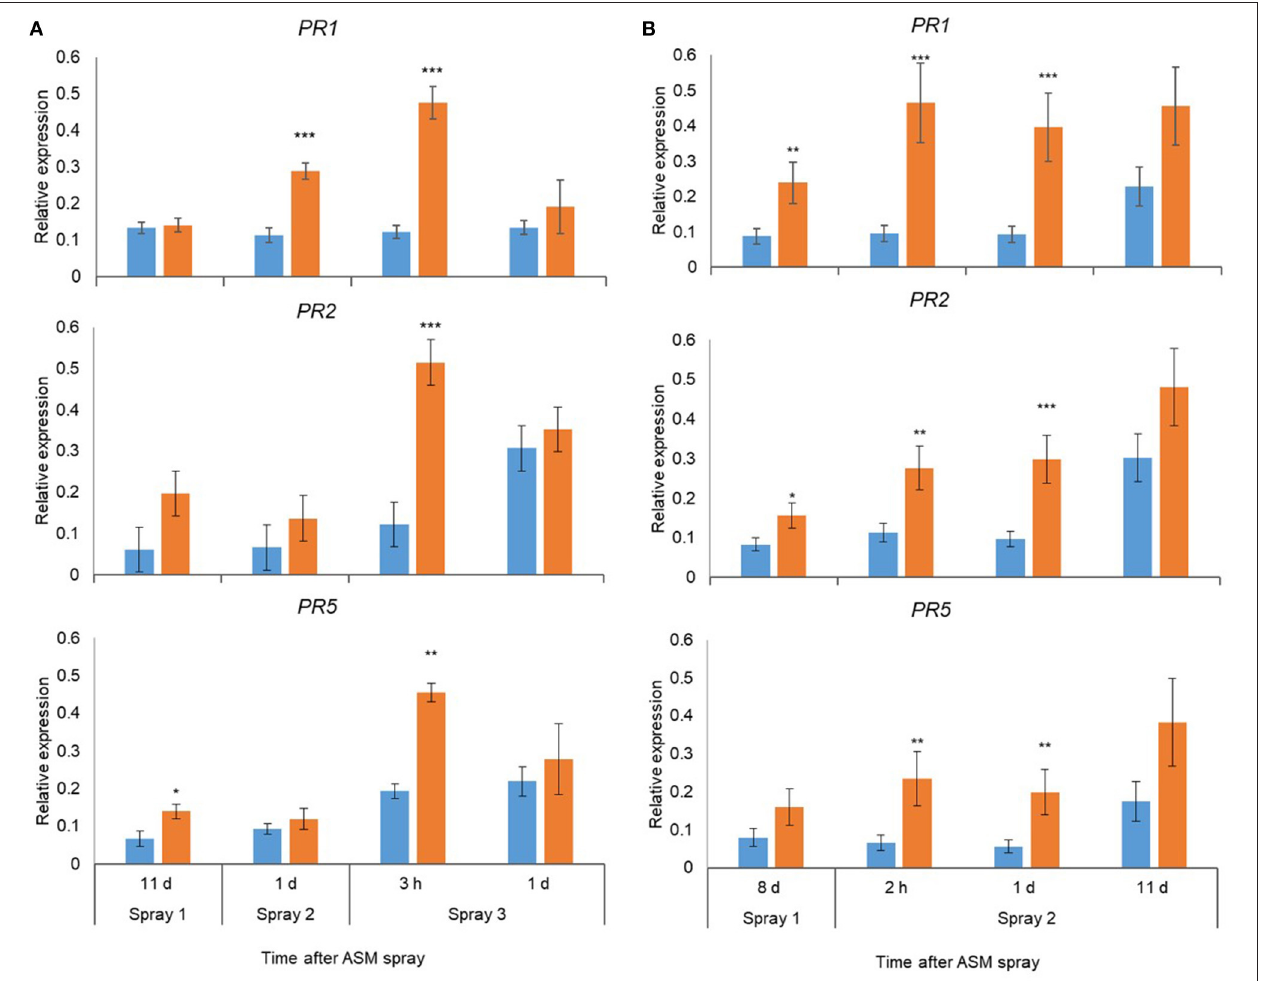
FIGURE 3 | Expression of PR1, PR2, and PR5 in leaves of Actinidia chinensis var. deliciosa ‘Hayward’ (A) and A. chinensis var. chinensis ‘Zesy002’ vines (B) at different times after Actigard (ASM) application during spring in 2017. Actigard (ASM) was sprayed on ‘Zesy002’ on 10 October, and 19 October, and on ‘Hayward’ on 19 October, 31 October, and 9 November. Gene expression was quantified by qPCR using 40S rRNA ( 40S ) and protein phosphatase 2A as the reference genes for ‘Hayward,’ and 40S and GAPDH as the reference gene for ‘Zesy002.’ Data were log 2 transformed for analysis, but are presented as back-transformed means. Asterisks above bars indicate significant treatment differences, where * < 0.05, ** < 0.01, and *** < 0.001.